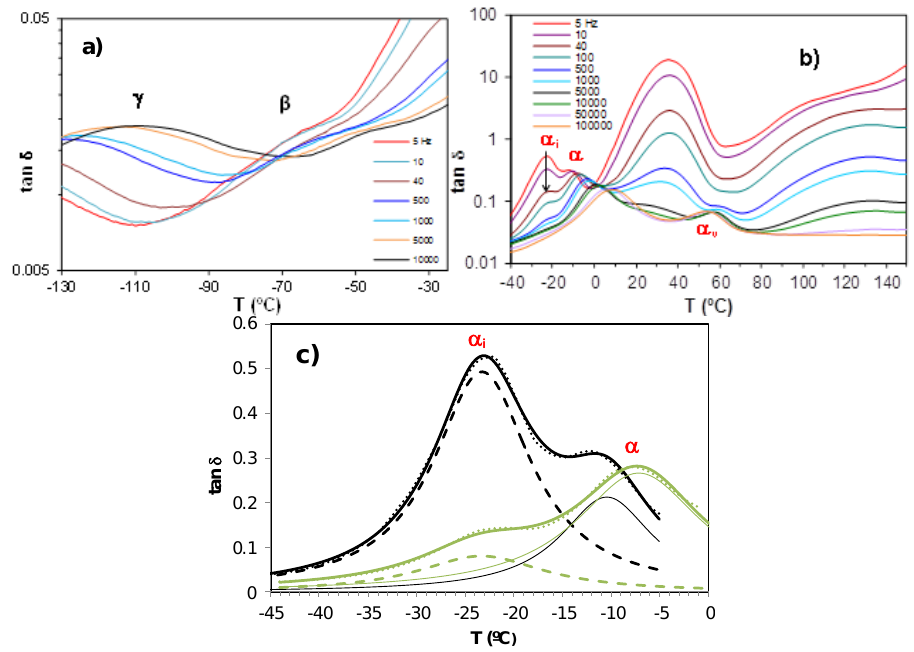
Figure 10. Dielectric relaxation spectrum for the ELP sample at heating rate of 0.5 K/min: ( a ) from −130 to −30 °C; ( b ) from −40 to 150 °C; ( c ) deconvolution of peaks at 5 Hz (black) and 40 Hz (green), showing experimental data (dotted lines), fit (thick lines), first peak (dashed lines) denoted α i and second peak (thin lines) denoted α.